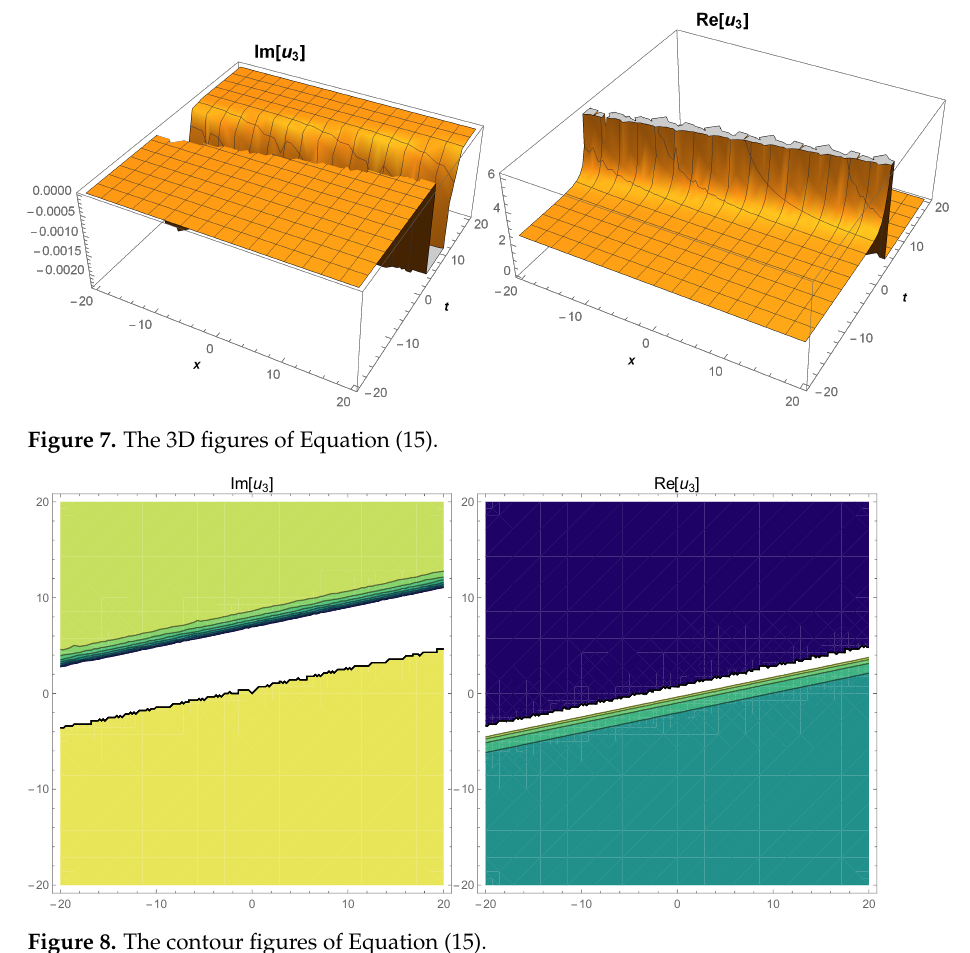
Figure 8. The contour figures of Equation